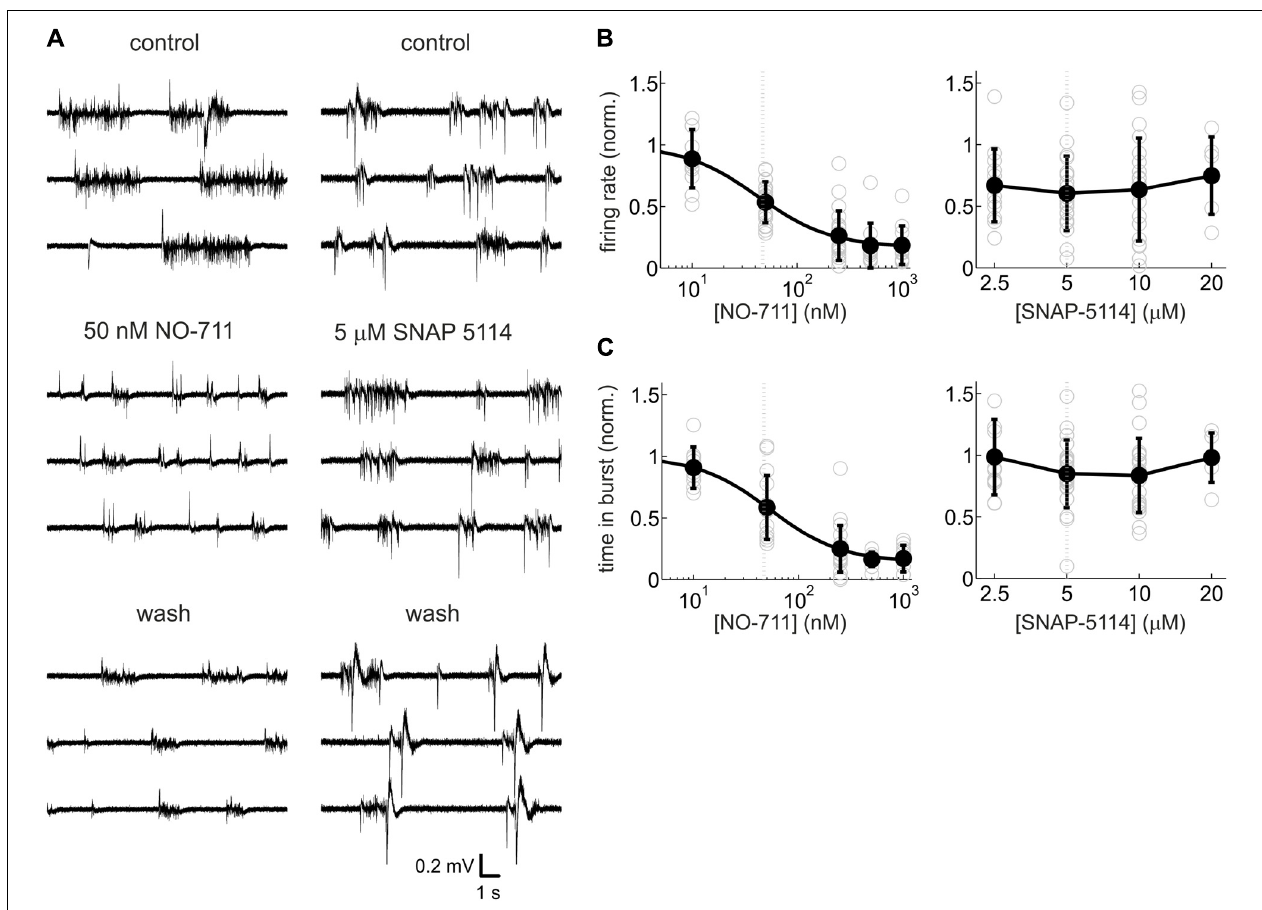
FIGURE 2 |Activity-depressant effects of the GAT-1-selective blocker NO-711 and the GAT-2/3 preferring antagonist SNAP-5114. (A) Example extracellular recordings (broadband signal) with both drugs at concentrations close to the IC 50 of their most sensitive molecular targets. 50 nm NO-711 diminished spontaneous activity strongly, whereas 5 μ M SNAP-5114 had a weaker effect.The effects of NO-711 were only partly reversible upon washout (Gonzalez-Burgos etal., 2009). (B) Concentration–response curves of NO-711